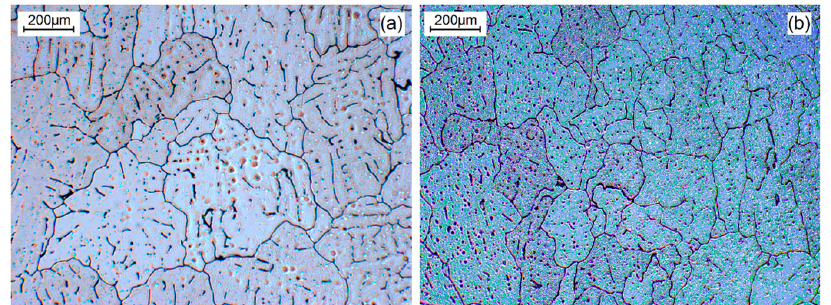
Figure 3. Experiment 2: ( a ) The grain size of untreated metal (204 ± 13 μ m) and ( b ) after treatment (147 ± 4 μ m) decreased by about 28%.